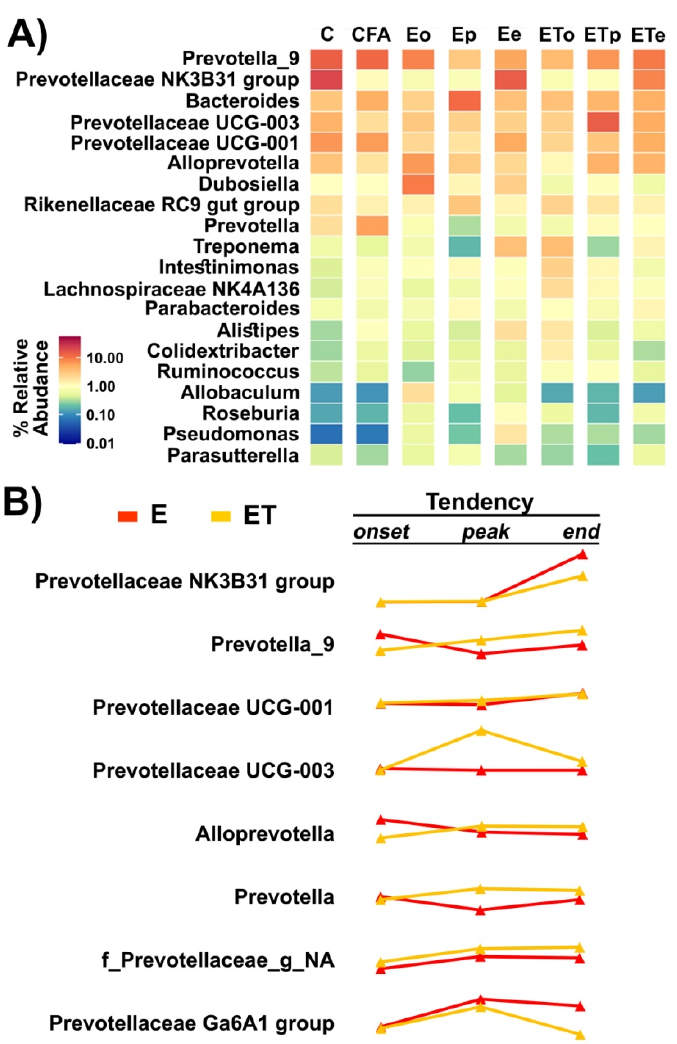
Figure 7. Gut microbiota analysis at the Genus level— ( A ) The abundance-based heatmap of the top 20 bacterial genera ( B ) The trend of change of relative abundance of genera within the Prevoteallaceae family for VBC-treated and untreated EAE animals during the course of the disease.